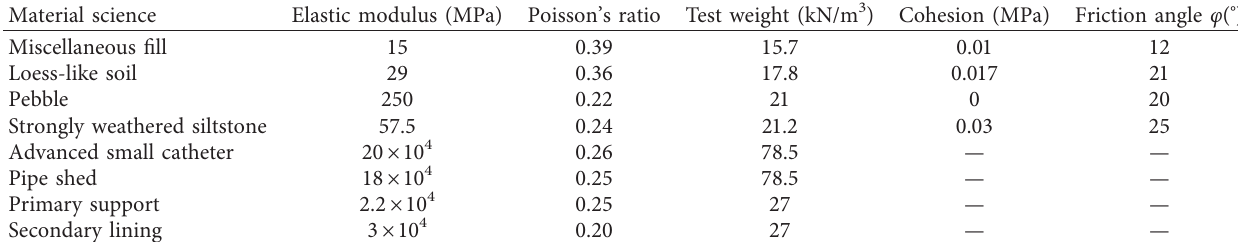
Table 1: Supporting and soil physical and mechanical